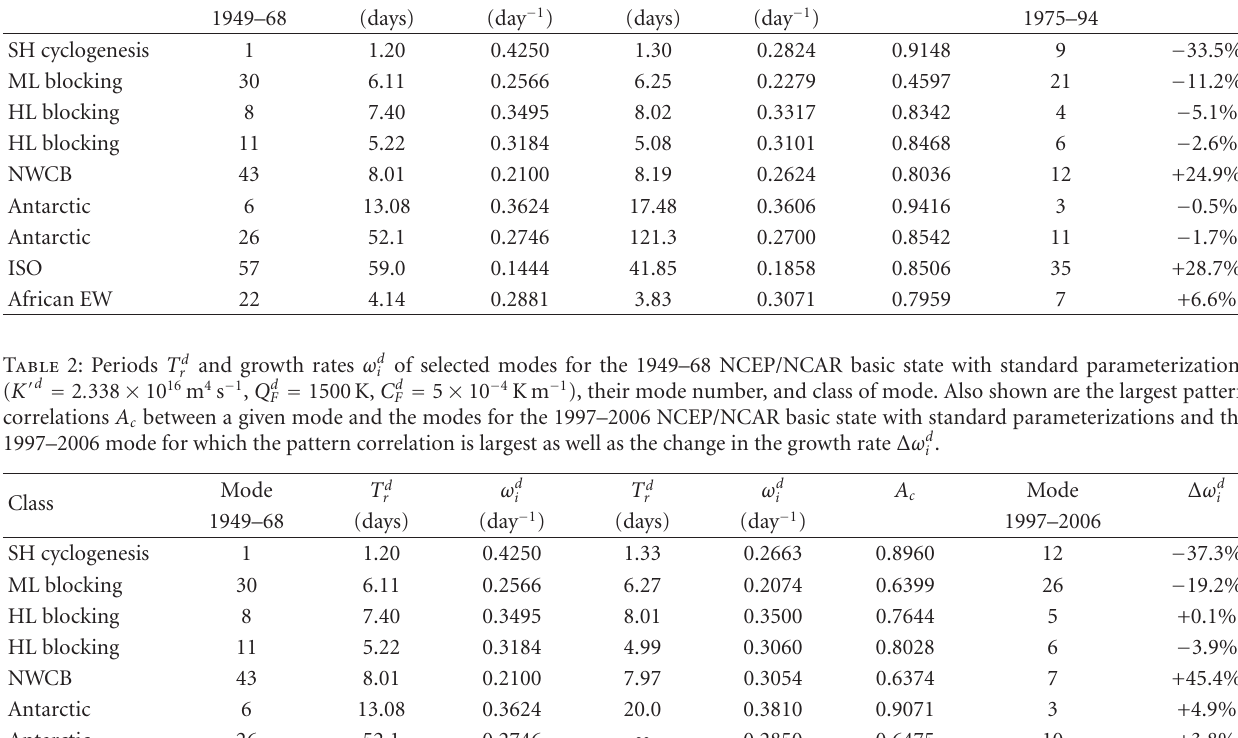
Table 1: Periods T d and growth rates ω d of selected modes for the 1949–68 NCEP/NCAR basic state with standard parameterizations i r